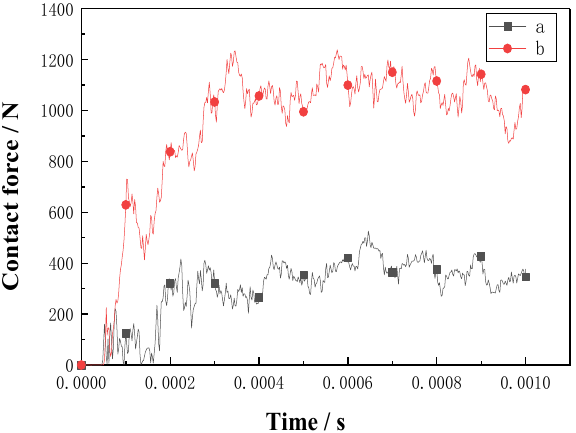
Figure 17. Plots of contact force vs. time for the bending of slot resin rib structure.